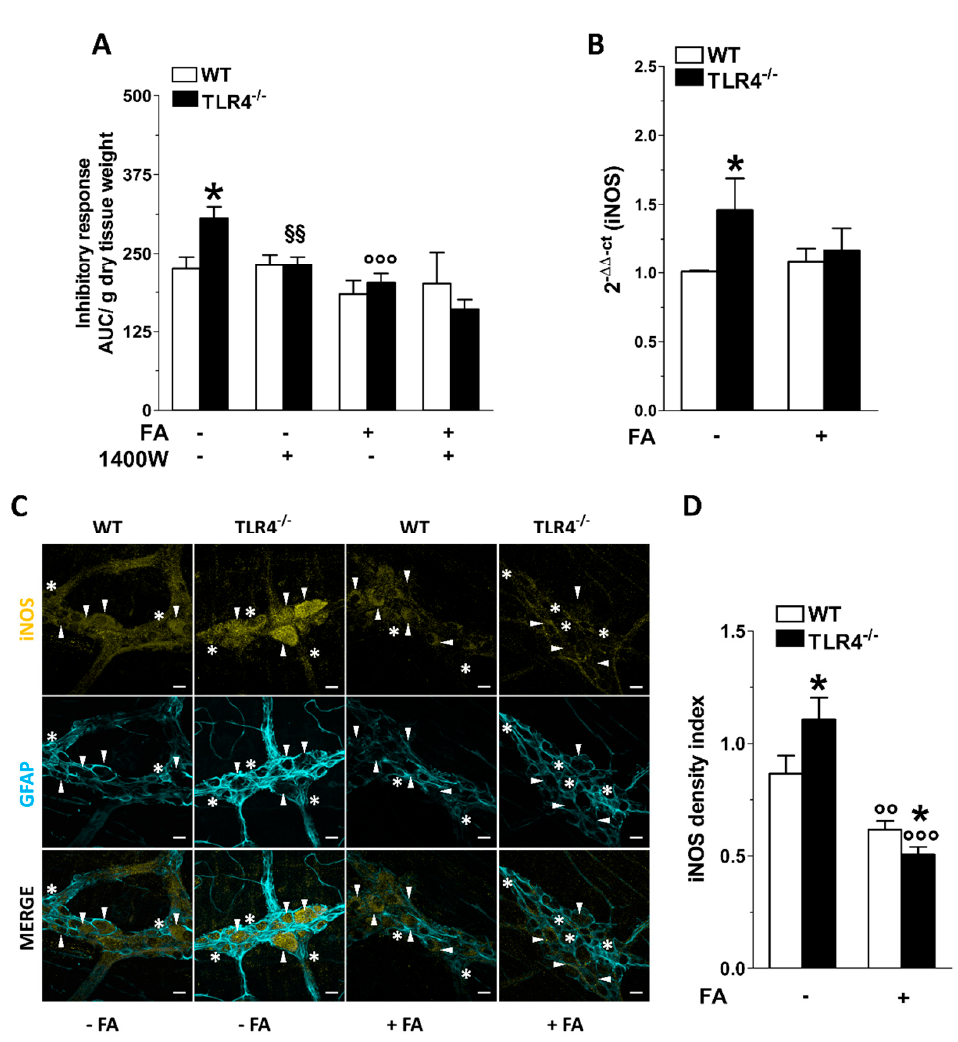
Figure 4. TLR4 signaling and EGC activity influence NO-mediated relaxation. ( A ) 10 Hz EFS-evoked relaxation in NANC conditions with or without 10 µM FA or 10 µM 1400 W (iNOS inhibitor) in ileal segments of WT and TLR4 − / − mice. ( B ) qRT-PCR quantification of iNOS mRNA levels in small intestine segments of WT and TLR4 − / − mice in the presence or absence of 10 µM FA. ( C ) Representative confocal microphotographs showing the distribution of iNOS (yellow) and GFAP (cyan) and ( D ) analysis of iNOS density index in ileal LMMPs of WT and TLR4 − / − mice in the presence or absence of 10 µM FA (bars = 22 µm). White arrowheads indicate iNOS + neurons, stars indicate iNOS + glial cell bodies, respectively. Data are reported as mean ± SEM for all panels. * P < 0.05 vs WT; °° P < 0.01, °°° P < 0.001 vs respective control without FA; §§ P < 0.01 vs respective control without 1400 W; N = 6 mice/group.